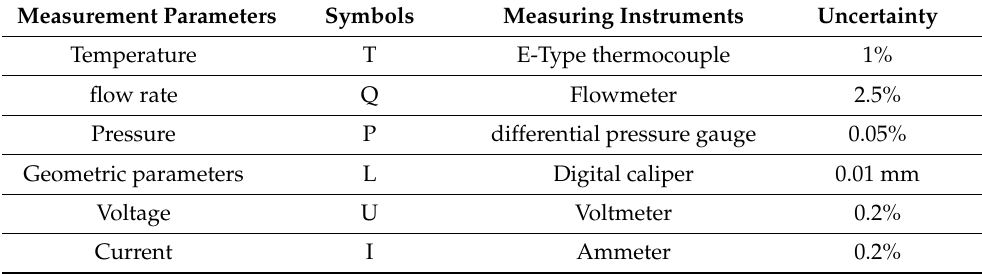
Table 1. Measuring instruments and the uncertainty.